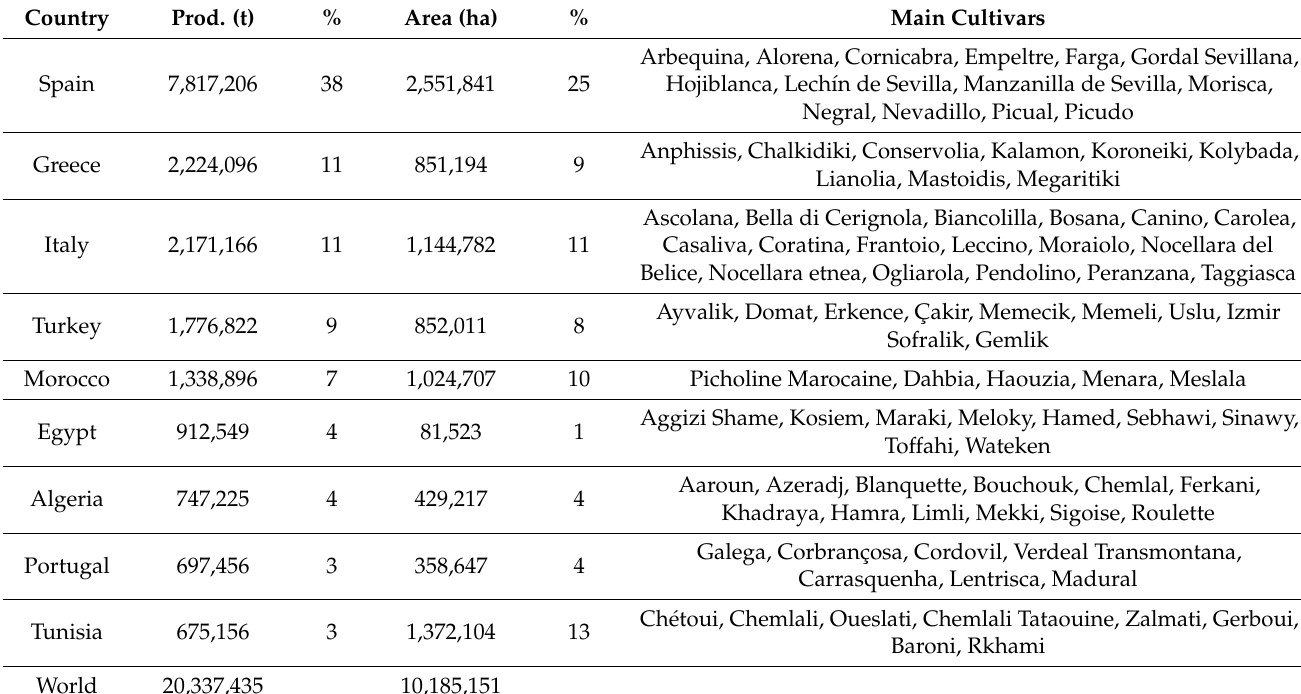
Table 1. List of the top countries regarding olive tree production and area (2016–2018) [7], and also the list of the most used cultivars in each country